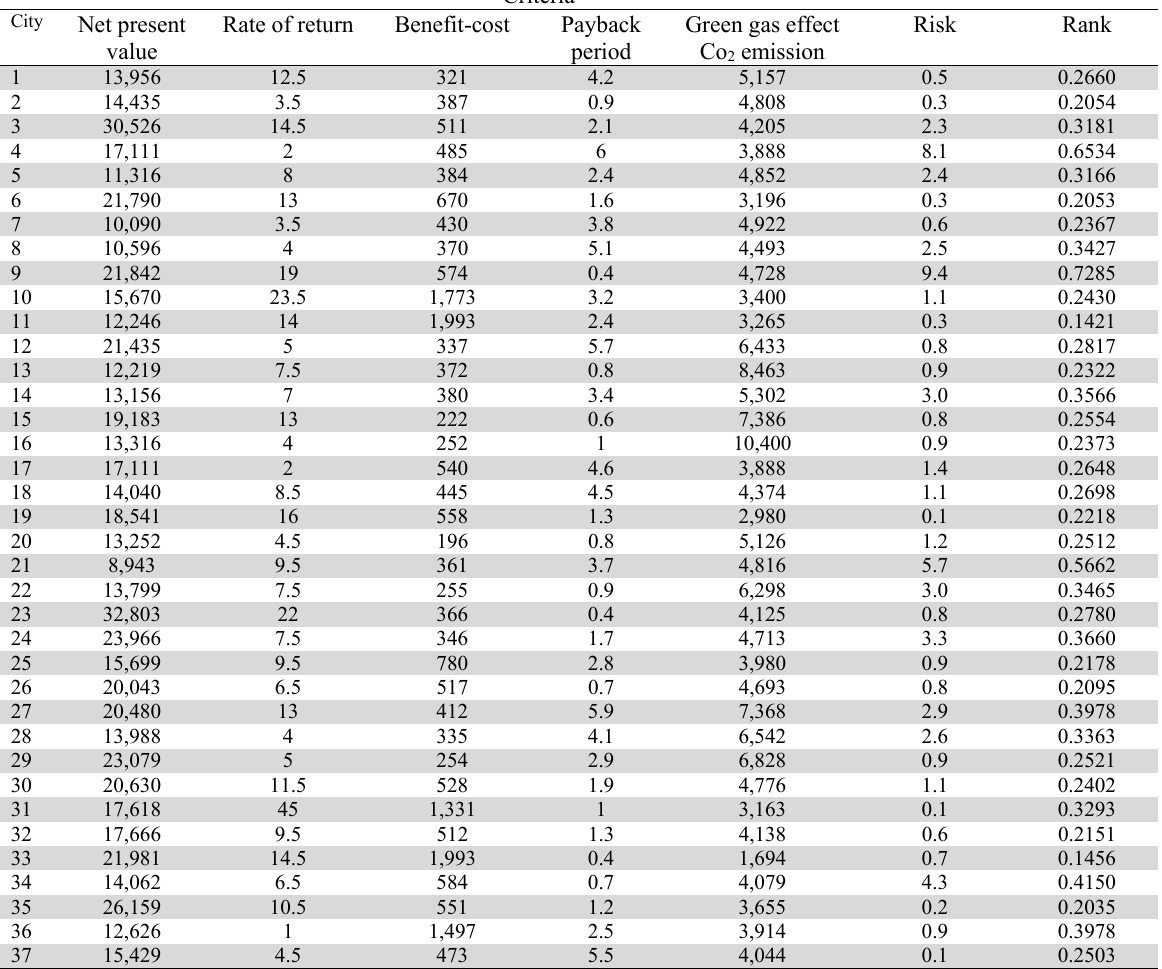
Input parameters for 37 projects along with the result of TOPSIS method